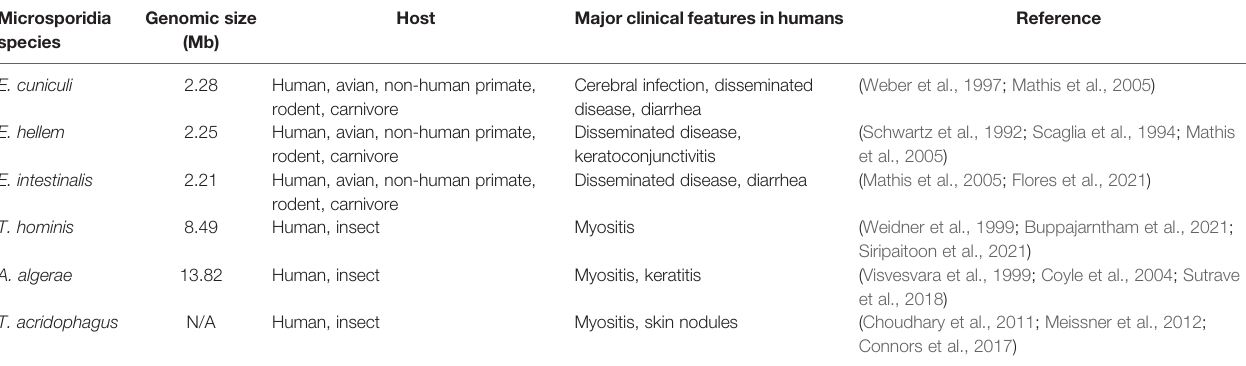
TABLE 1 | Host spectrum of Microsporidia spp. which can cause systemic infection and other major clinical fi